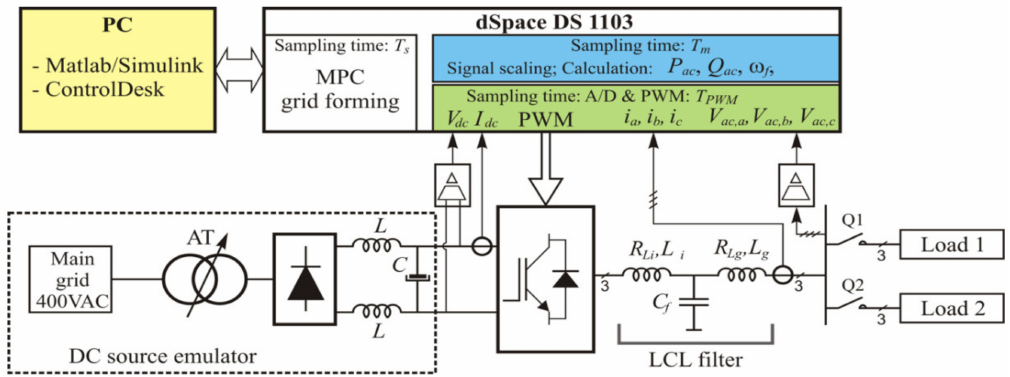
Figure 7. Experimental electrical layout with evidence of the measuring points and RPC set-up.